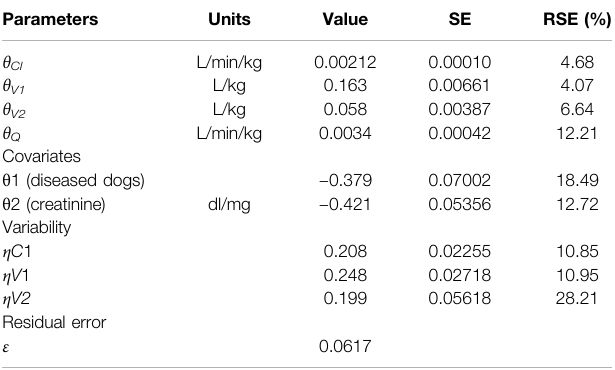
TABLE 2 | Synthesis of estimates obtained in the fi nal Pop PK model.